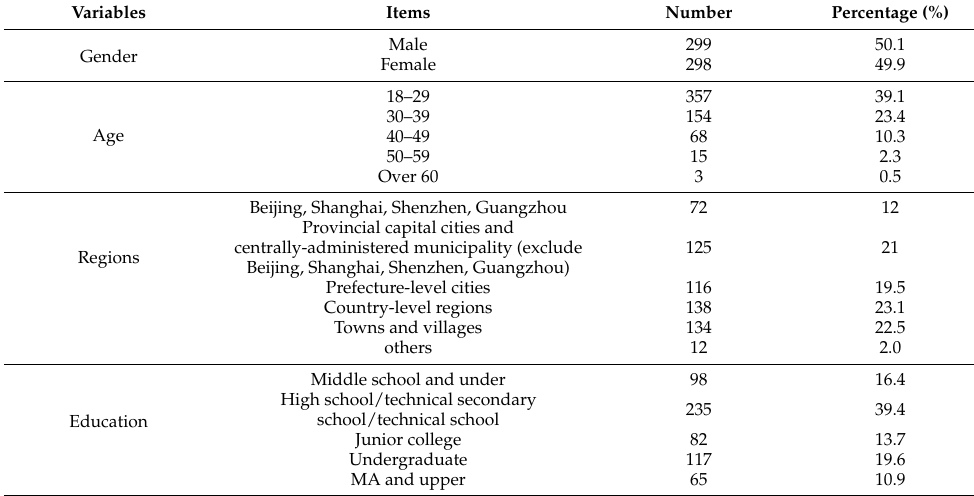
Table 2. Demographics of survey